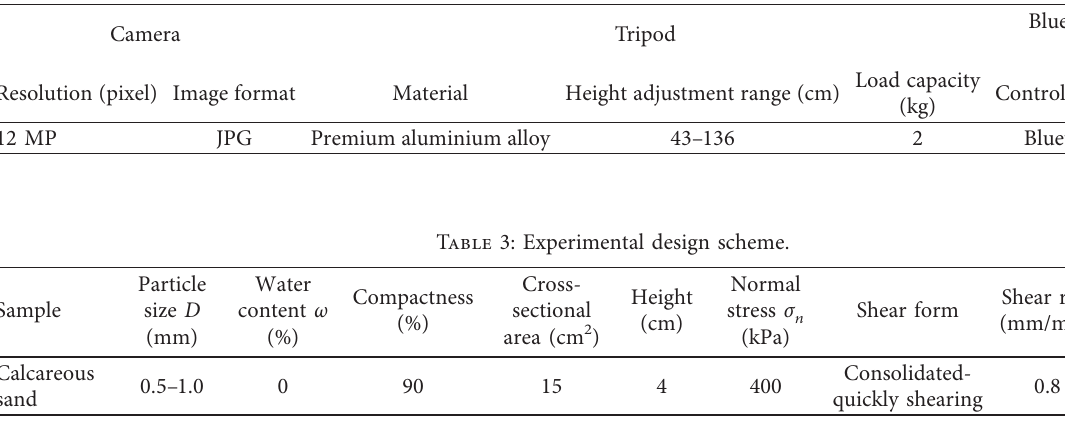
Table 2: Technical parameters of the image acquisition system.